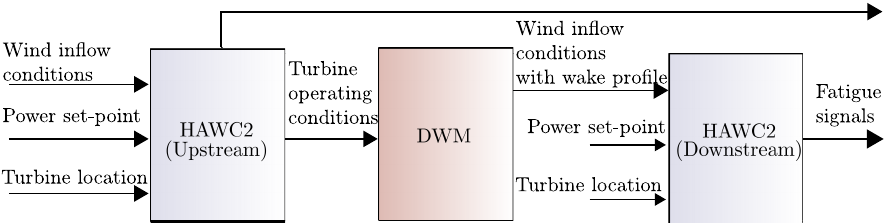
Figure 2. Illustration of the HAWC2-DWM framework for the prediction of turbine component fatigue damage.